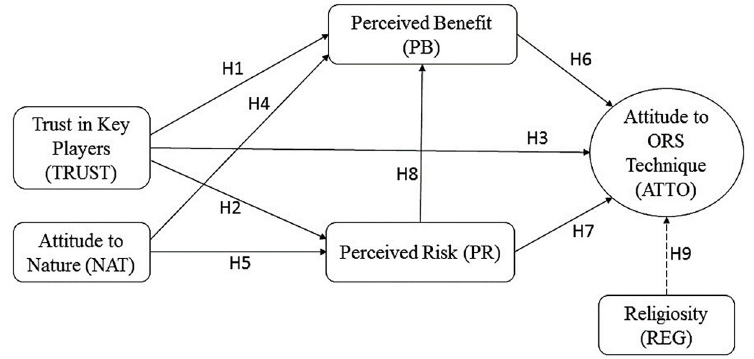
Fig 1. Research framework for predicting factors and religiosity as a moderator in understanding the attitudes of stakeholder toward the ORS technique.